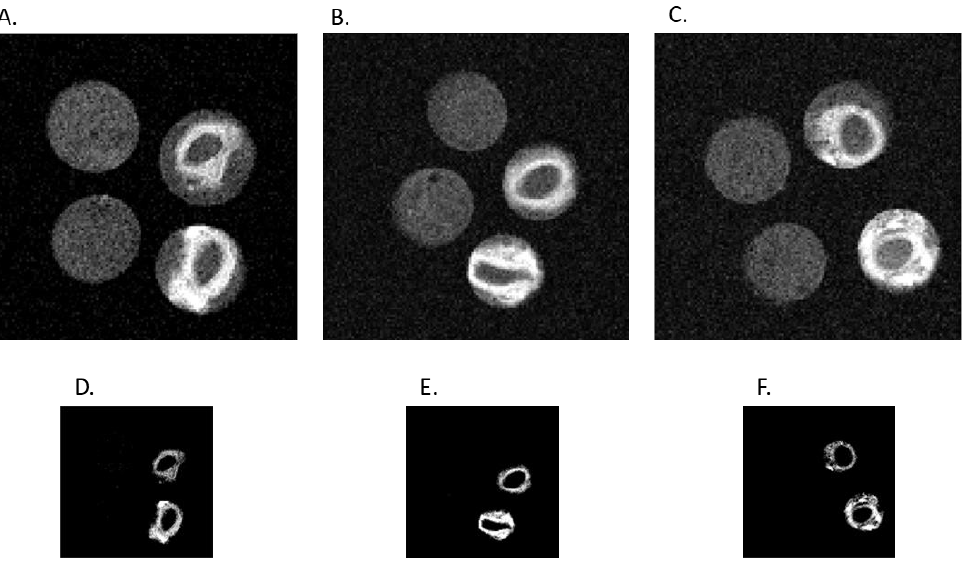
Figure 7. T1-weighted MR images of healthy abdominal artery (H) and abdominal artery aneurysm (AAA) immersed in Dotarem and Gd-SF (H-Do, AAA-Do, H-Gd-SF, and AAA-Gd-SF). (( A , D ), Lot 1; ( B , E ), Lot 2; ( C , F ), Lot 3. n = 3. Top left, H-Do; top right, H-Gd-SF; bottom left, AAA-Do; bottom right, AAA-Gd-SF. ( D – F ) brightness/contrast adjustment).